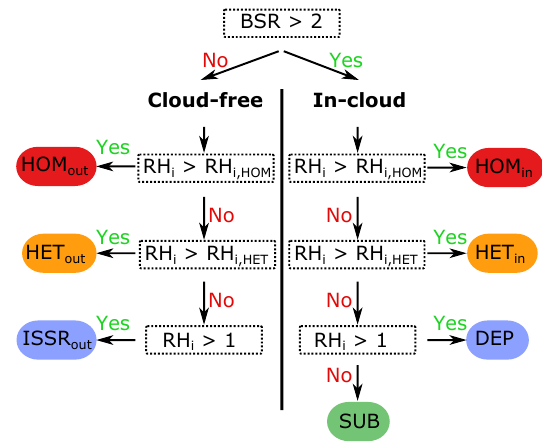
Figure 1. Cirrus evolution classification scheme based on WALES backscatter ratio (BSR) and relative humidity (RH i ) derived from WALES humidity and ECMWF temperature field (description see text). Table 1. Freezing onset humidity